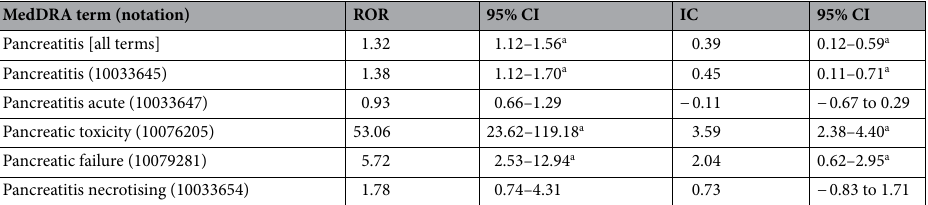
Table 3. Disproportionality analysis for pancreatitis associated with tocilizumab use. CI confidence interval, IC information component, MedDRA medical dictionary for regulatory activities, ROR reporting odds ratio. a Statistically significant.